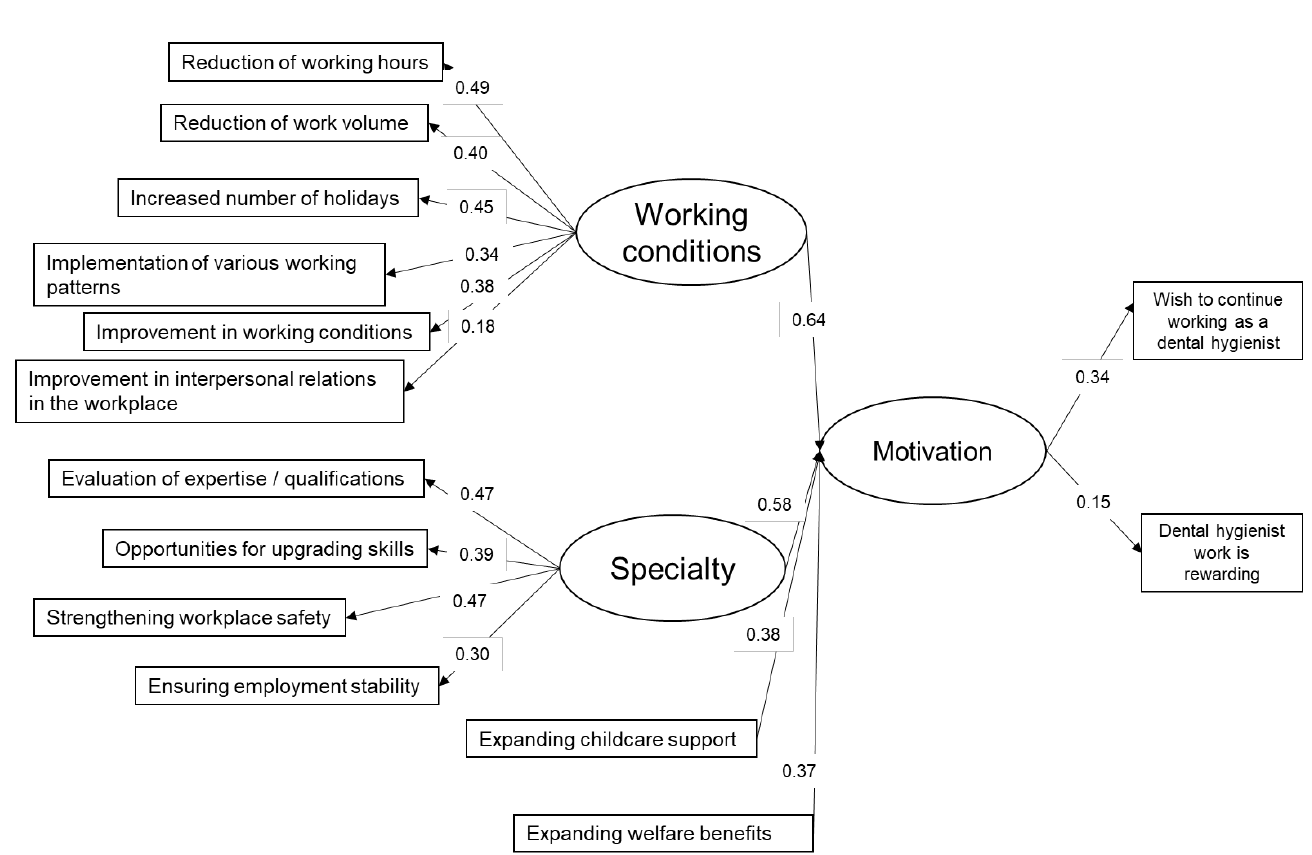
Figure 2. The path diagram of the motivation and working conditions that Japanese dental hygienists wish to improve. A path from “Working conditions” to “Motivation” was higher than that of “Specialty”. Among all observed variables that construct “Working conditions”, coefficients of “Reduction of work volume”, “Reduction of working hours” and “Increased number of holidays” were higher than other items.